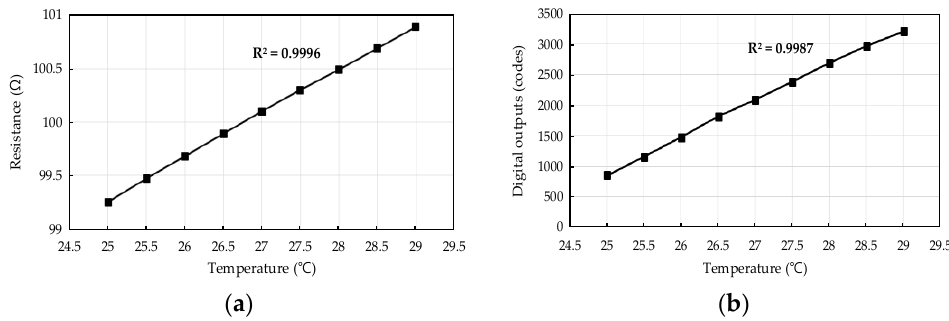
Figure 13. ( a ) Resistance measurement results based on temperature of manufactured air flow sensor; ( b ) digital output code measurement results based on temperature of fabricated four-channel low-noise readout IC.